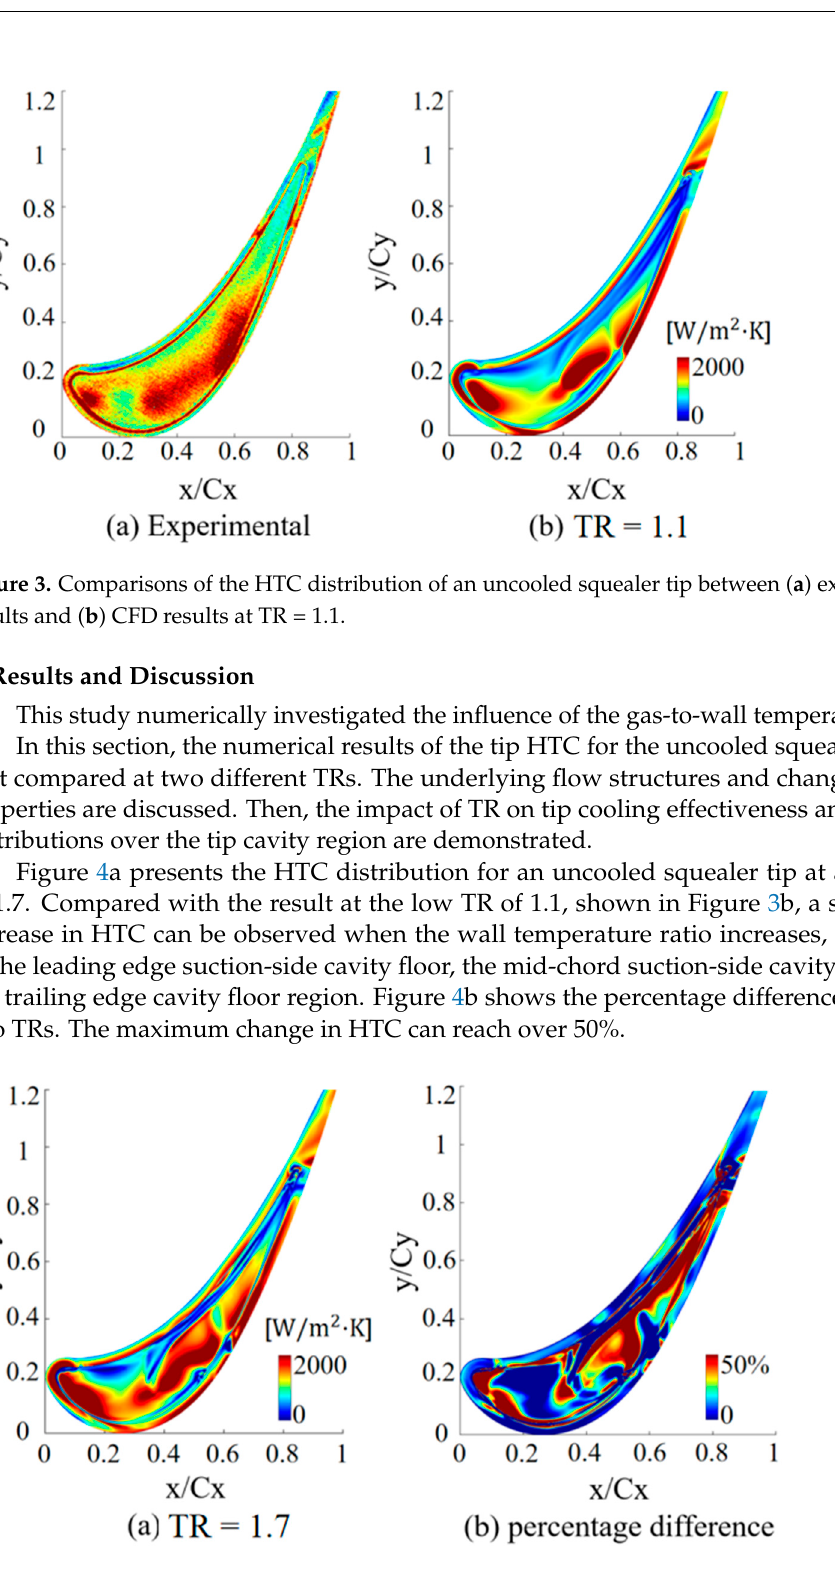
Figure 4. For the uncooled squealer tip: ( a ) HTC distribution for TR = 1.7, ( b ) percentage difference between two TRs.